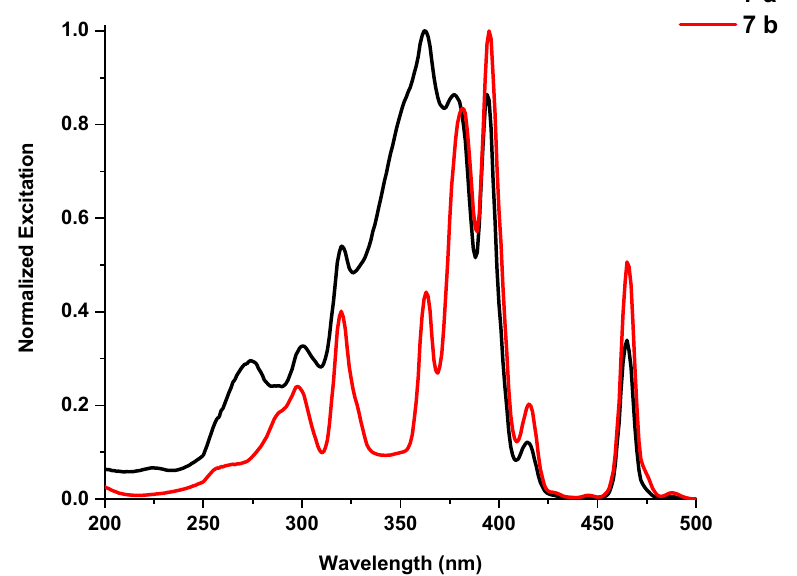
nescence excitation spectra of compounds 8 a – d in the solid state with emissions at 615 nm.